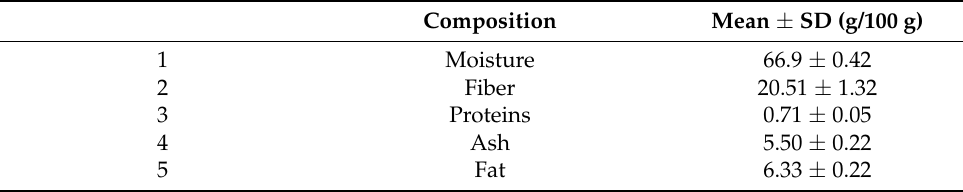
Table 1. Proximate chemical composition of fresh oregano leaves.